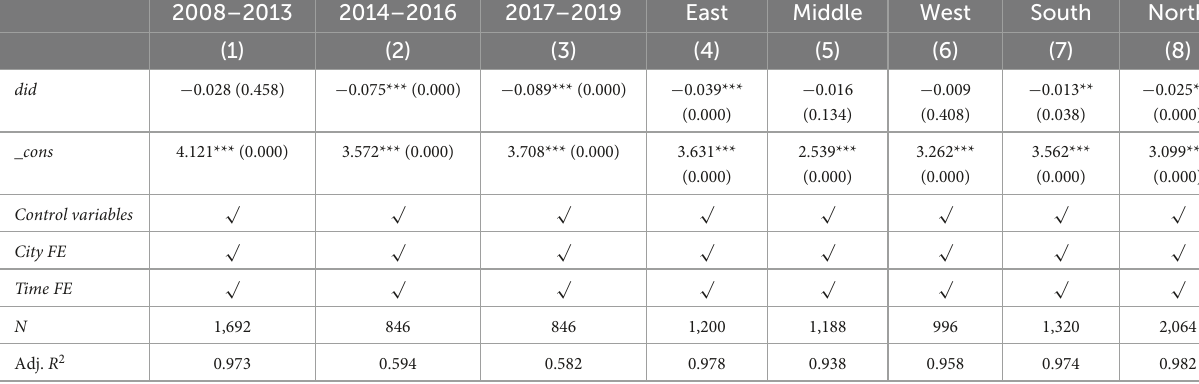
TABLE 5 Heterogeneity analysis of time and geographical location.